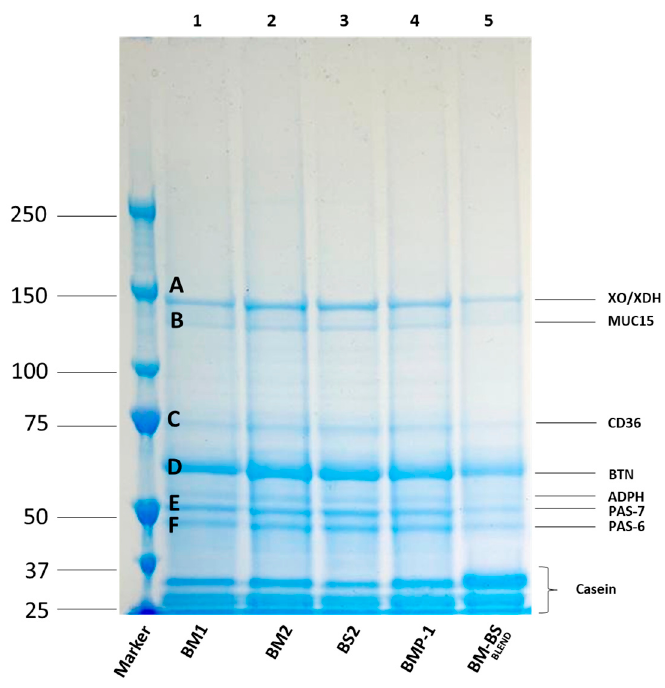
Figure 7. SDS-PAGE pattern of MFGM isolated from selected samples. XDH/XO: xanthine dehydrogenase/oxidase; MUC15: mucin; CD36: cluster of differentiation; BTN: butyrophilin; ADPH: adipophilin; PAS 6/7: glycosylation variants of lactadherin, marker: left column denotes the molecular weight markers (kDa). BM1: buttermilk 1, BM2: buttermilk 2, BS2: butter-serum 2, BMP-1: buttermilk powder, BM-BS BLEND: buttermilk and butterserum mix.